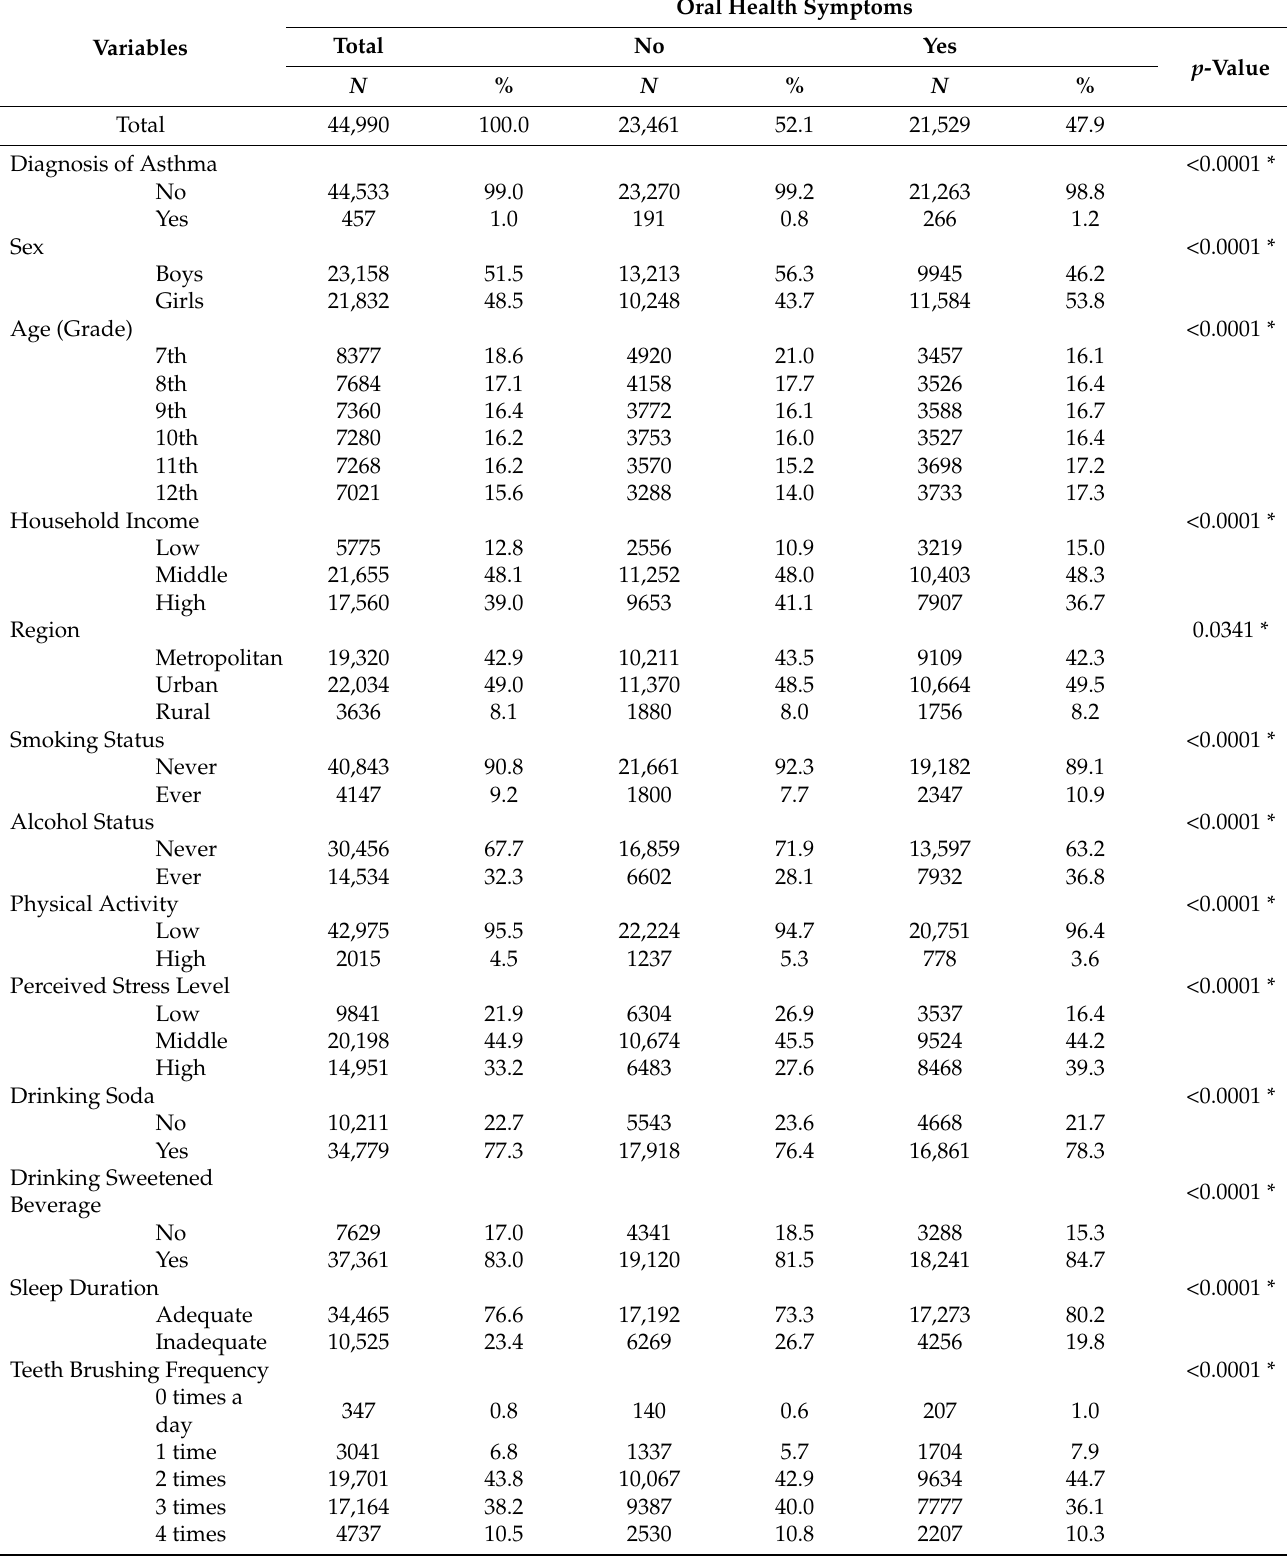
Table 1. General characteristics of the study